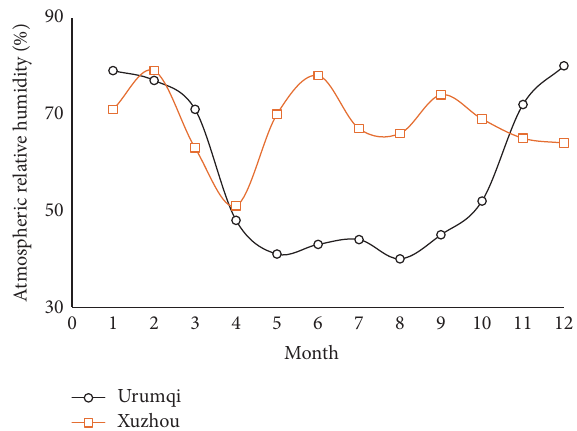
Figure2:MonthlyaveragerelativehumidityinUrumqiandXuzhou [18,